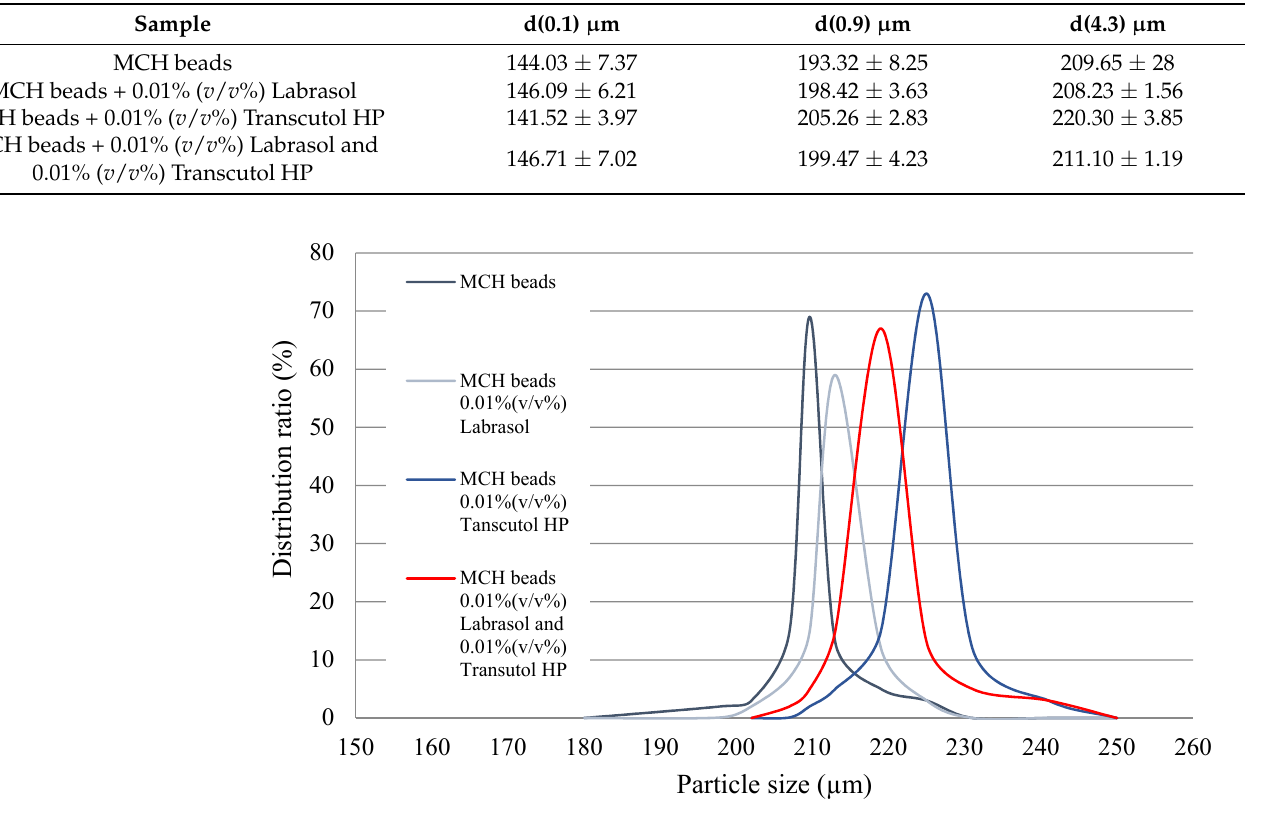
Figure 4. Results of laser diffraction particle size distribution according to the volume moment mean values. Particle size of the beads is close to the theoretical 200 µm regarding all four formulations.